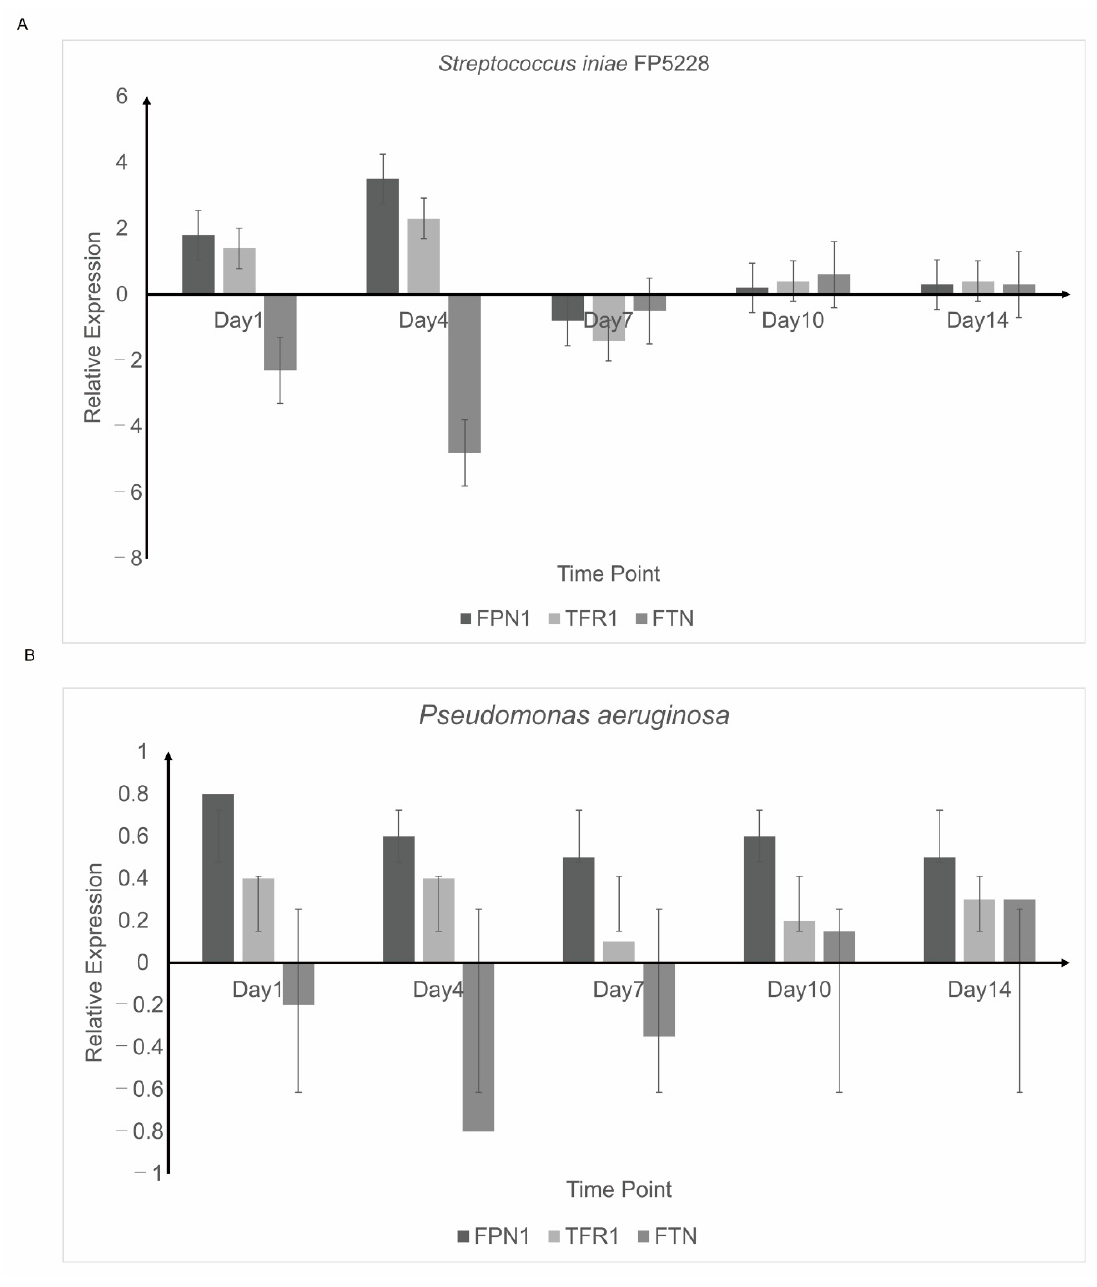
Figure 7. FPN1, TFR1, and FTN mRNA expression in the liver after bacterial infection. ( A ) FPN1, TFR1, and FTN mRNA expression in the liver after infection with Streptococcus iniae FP5228. ( B ) FPN1, TFR1, and FTN mRNA expression in the liver after infection with Pseudomonas aeruginosa